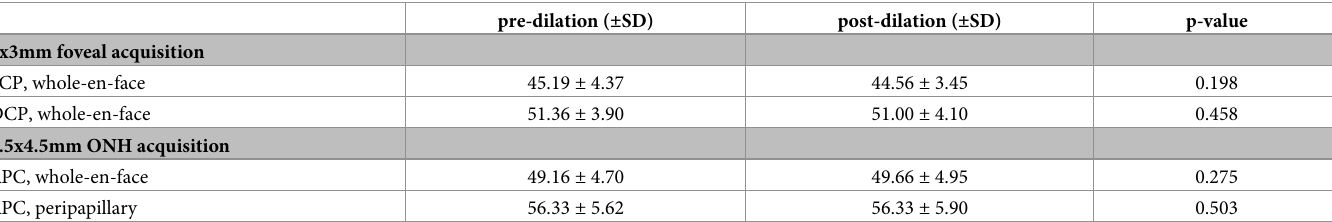
Table 2. Pre- and post-dilation FD